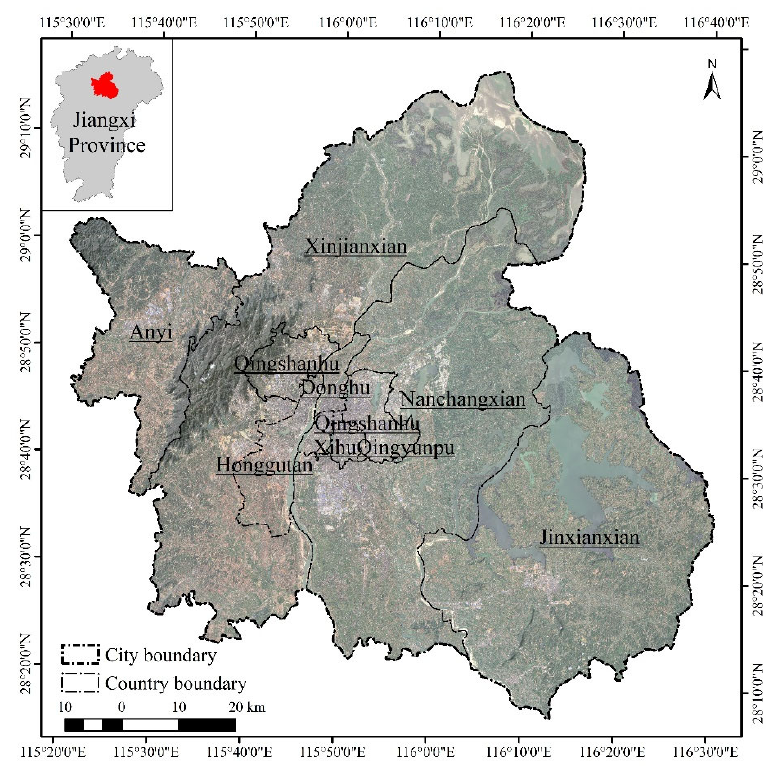
Figure 1. Nanchang Figure 1. Nanchang City.